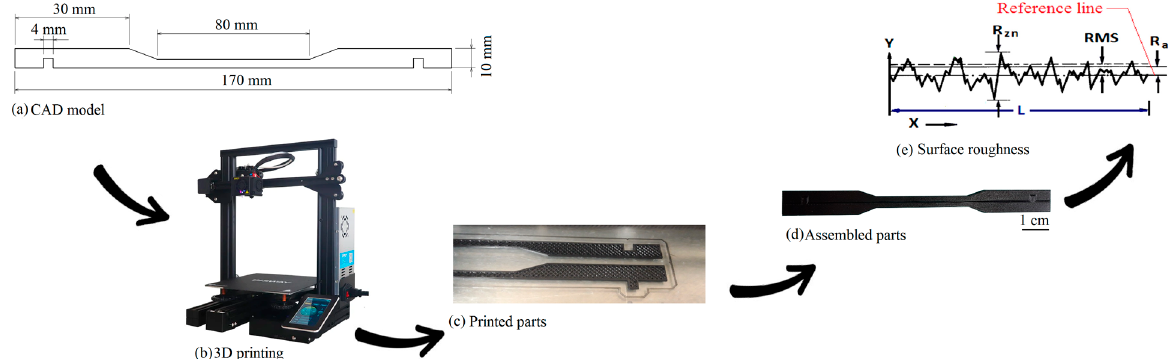
Figure 2. Schematic of 3D printing of joint parts. Table 2. Design of Experiments—input and output parameters.